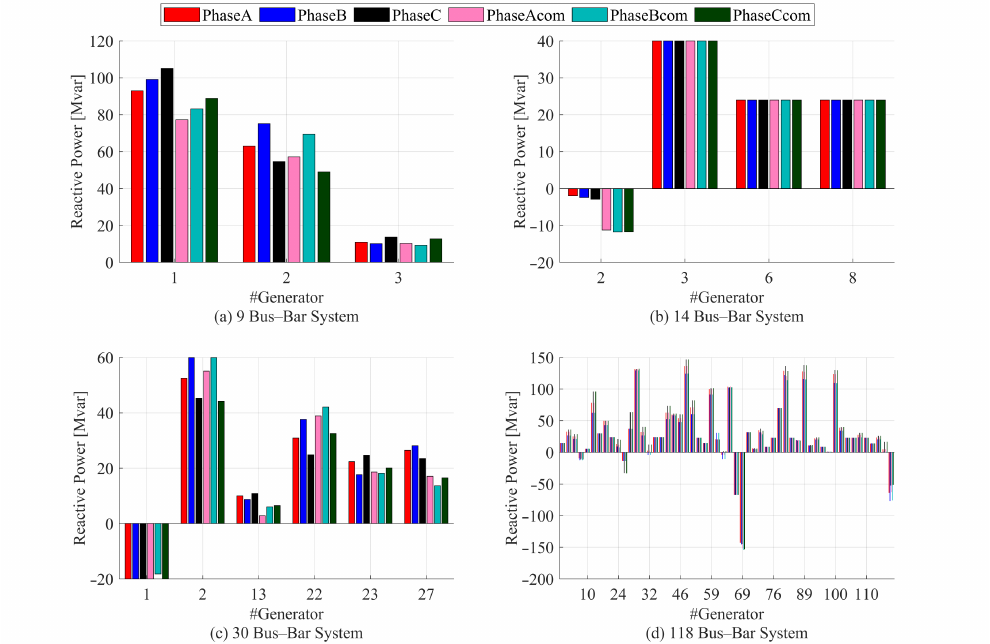
Figure 7. Dispatch of reactive power from generators.